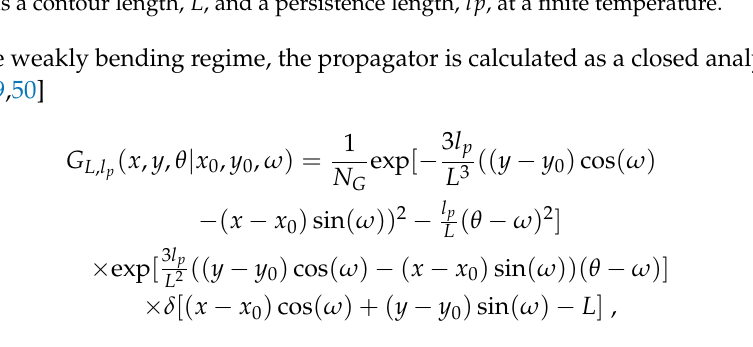
Figure 1. Left panel: the zero temperature configuration of the grafted wormlike chain (WLC) in two dimensions. Right panel: the grafted filament in the presence of thermal fluctuations. The position and orientation of the free endpoint of the filament fluctuate due to the finite temperature. The filament has a contour length, L , and a persistence length, lp , at a finite